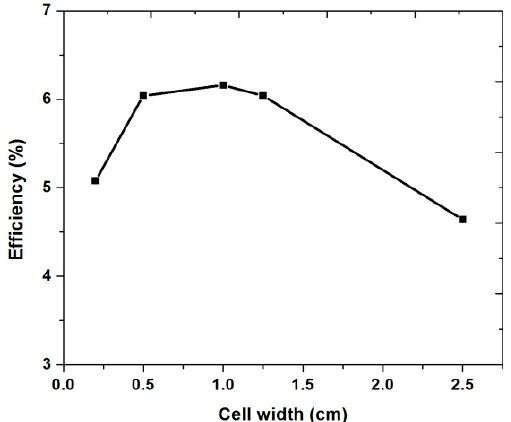
Figure 8. Variation of module efficiency with cell width.